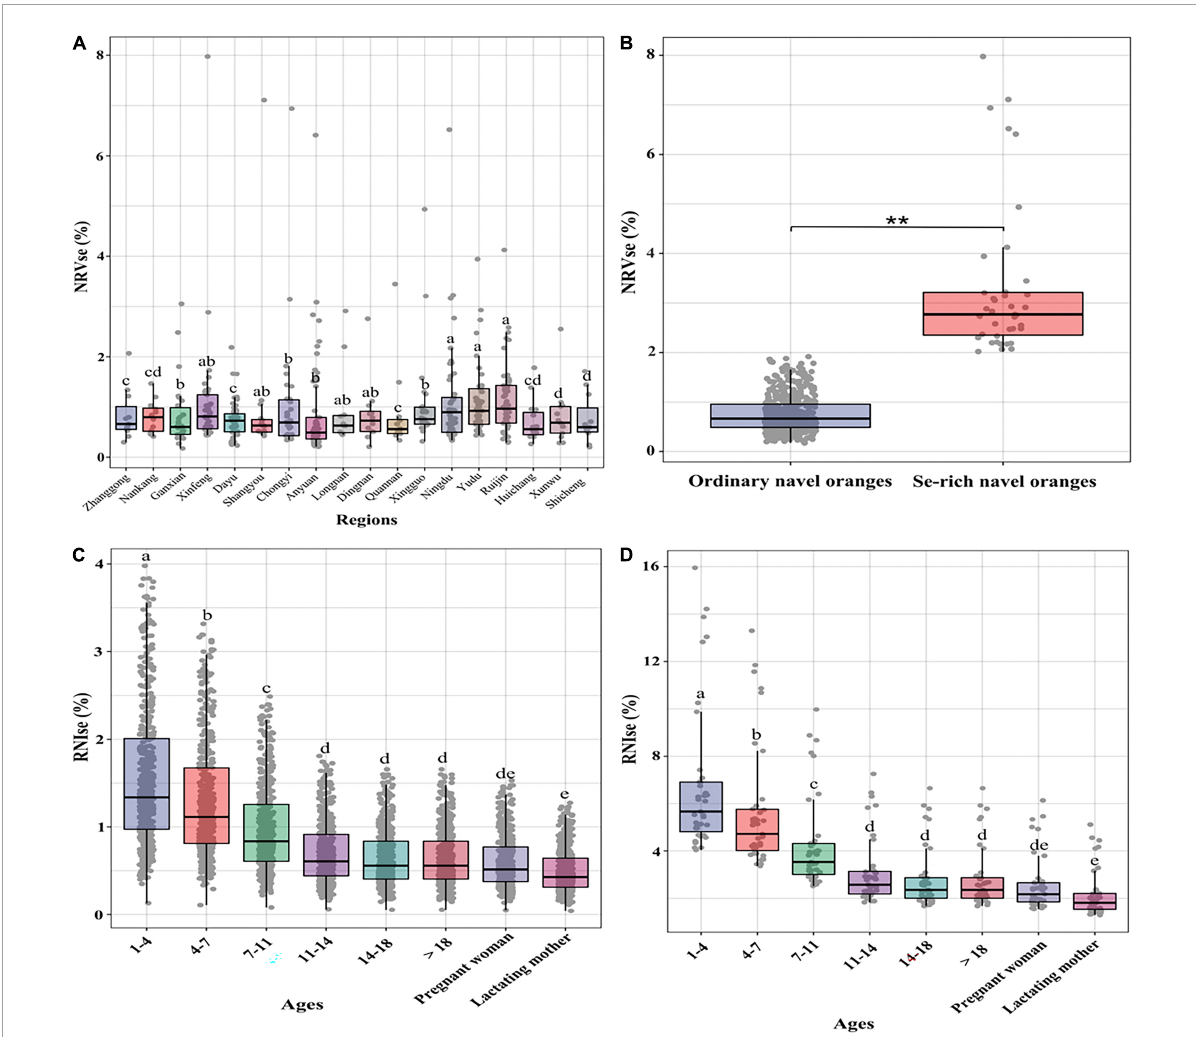
FIGURE5 The difference in NRVse in the study area (A) , the difference in NRVse between ordinary and Se-rich navel oranges (B) , and the difference in RNIse between ordinary (C) and Se-rich (D) navel oranges. Letters indicate a significant difference at p < 0.05 among treatments (** p < 0.01).